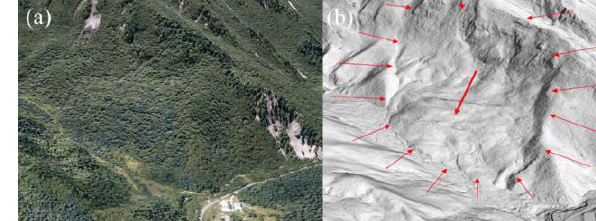
Figure 4. (a) is an optical remote sensing image, (b) is an ancient landslide body found after removing vegetation from airborne LiDAR data